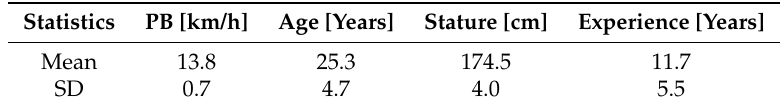
Table 1. Mean and standard deviation (SD) values among the participants related to: personal best on 20 km (PB), age, stature, and experience.